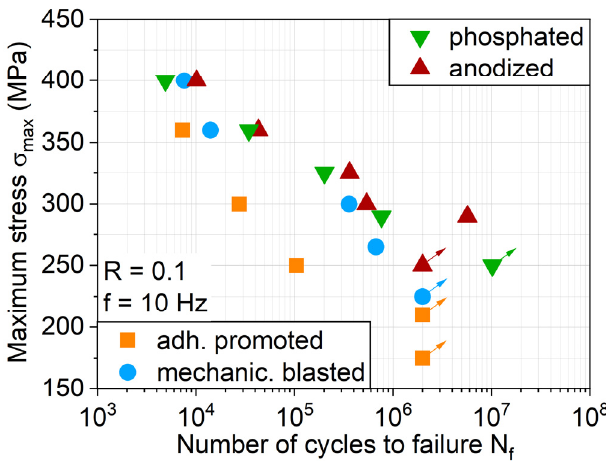
Figure 12. S-N relationship for hybrid laminates with different aluminum surface treatments.